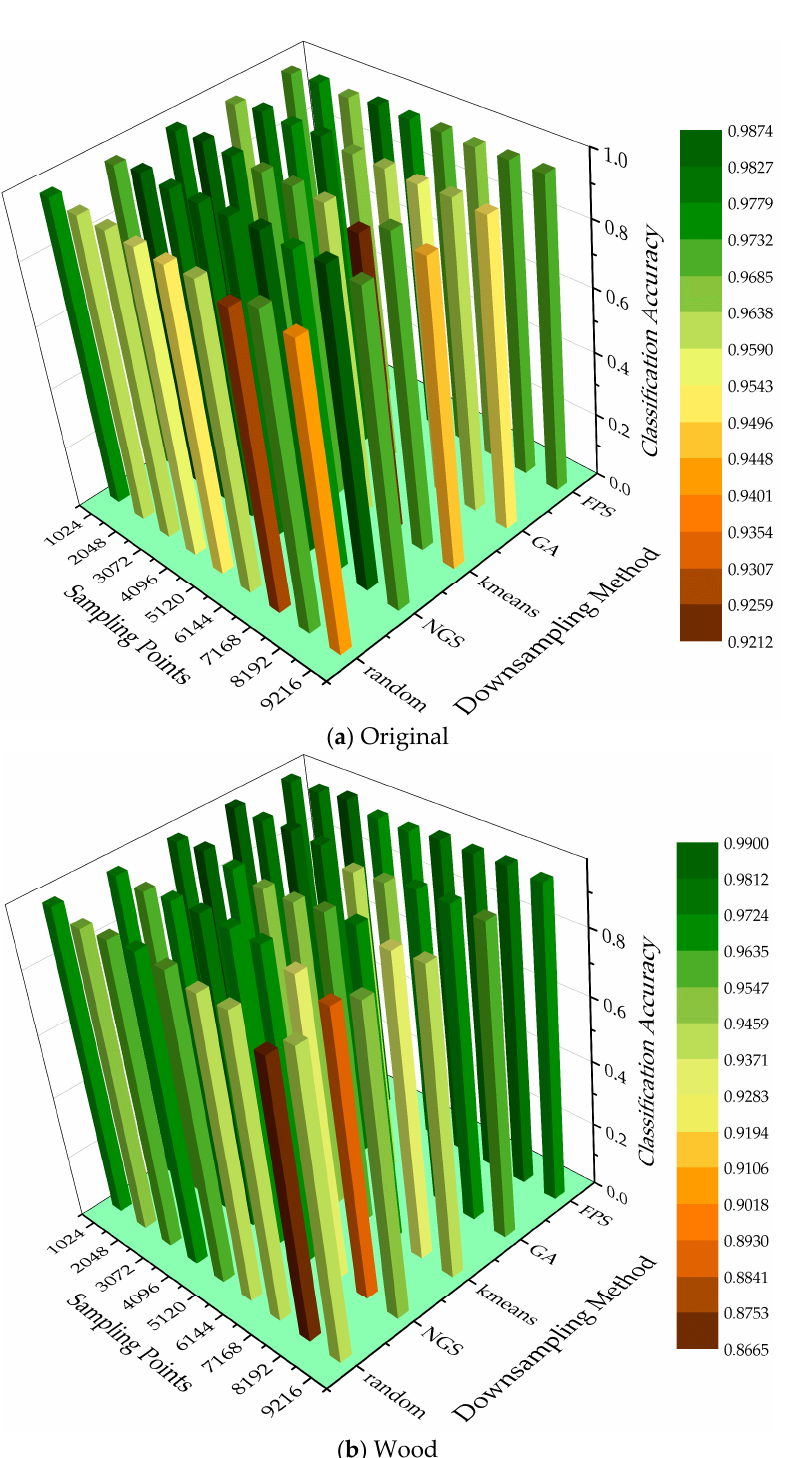
Figure 8. Accuracy of tree species classification in experiments with different downsampling methods: ( a ) point cloud data without leaf–wood separation; ( b ) point cloud data of the